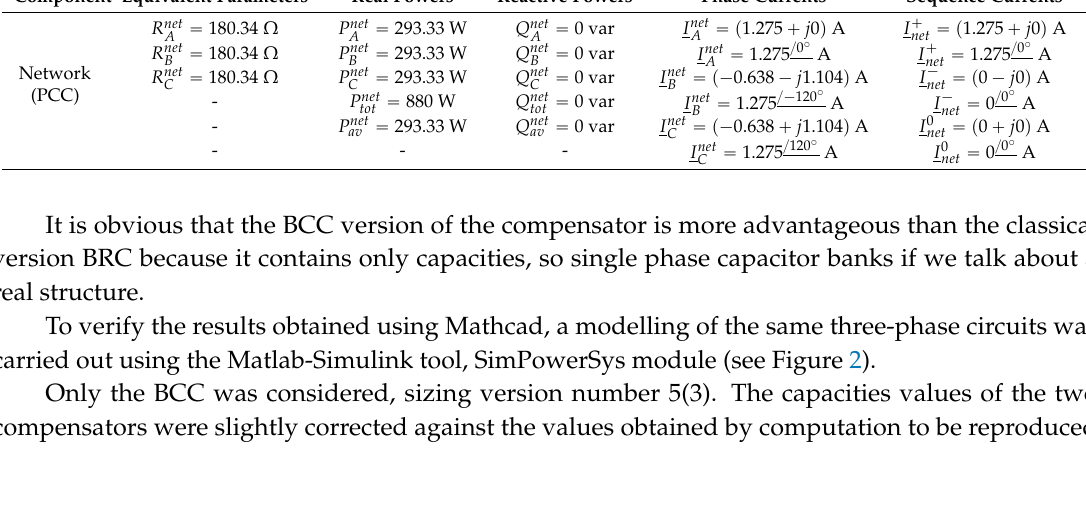
Table 4. The assembly load-compensator seen from the network (Point of Common Coupling (PCC)). Component Equivalent